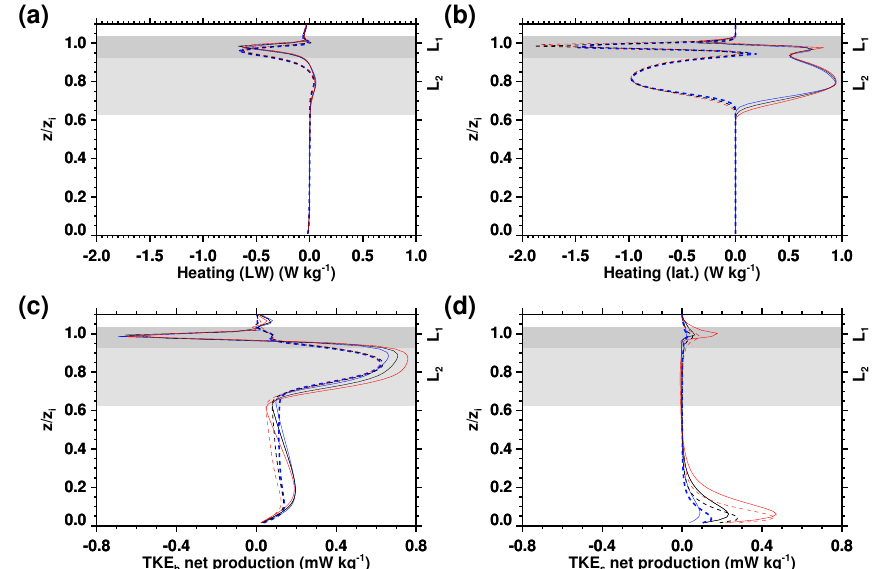
Figure 11. Longwave heating (a) , latent heating (b) , and TKE net production from buoyancy (c) and shear (d) , averaged over the period N (10:20–11:20UT) from the simulations M − (blue), M 0 (black), M + (red). Solid curves denote values from updrafts, dashed curves values from downdrafts. Updraft and downdraft values are air mass weighted sums over the updraft or downdraft locations at each level, respectively, normalized by the level air